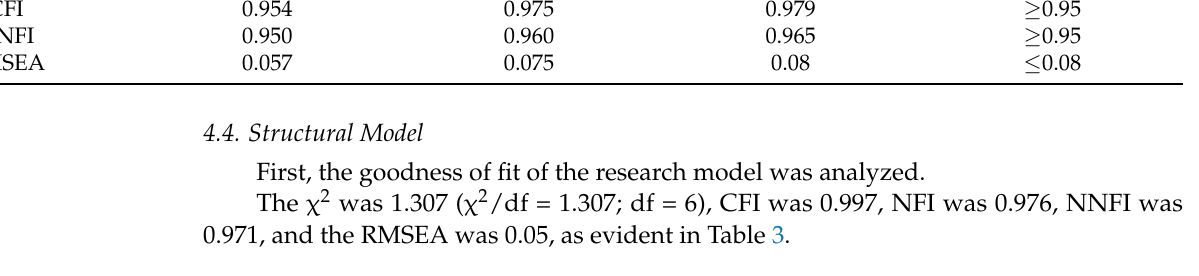
Table 3. Model fit statistics of the full composite